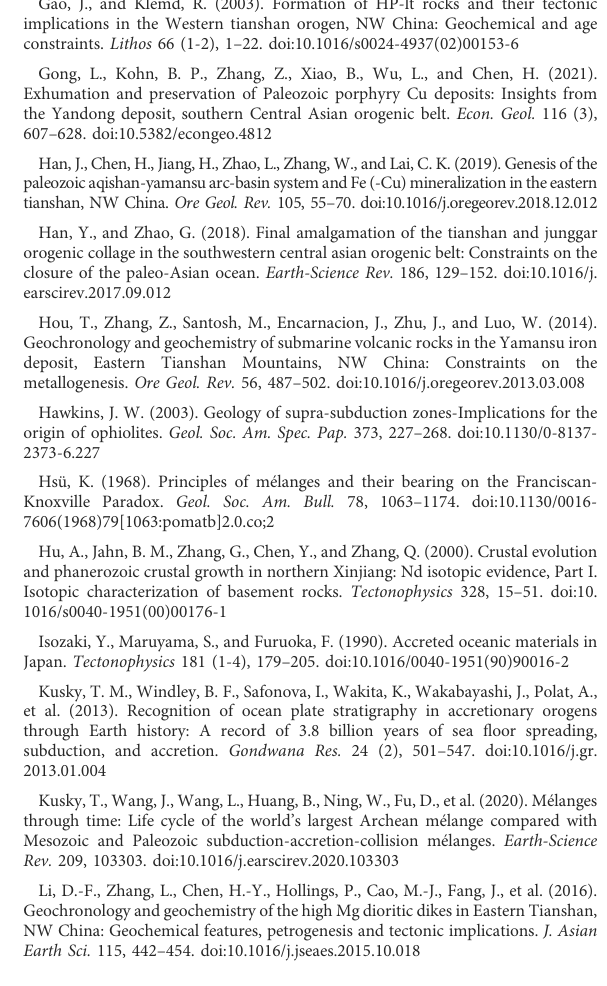
SUPPLEMENTARY TABLE S2 Lu ‒ Hf isotope data of zircons from the sedimentary matrix rocks in the KGSC in the Haluo area.